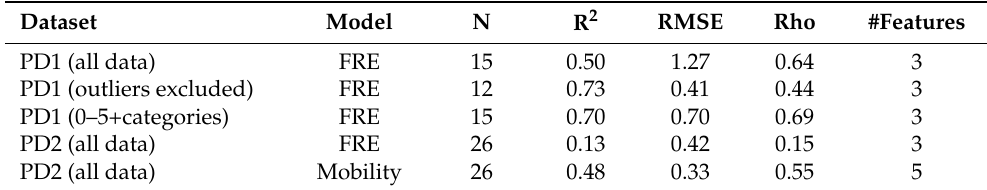
Table 2. Testing of existing QTUG data model using negative binomial falls count model fit to independent PD datasets. Results are presented for both the FRE and Mobility models. For the PD1 dataset, results are provided for all data as well as with outliers ( NumFalls > 10)